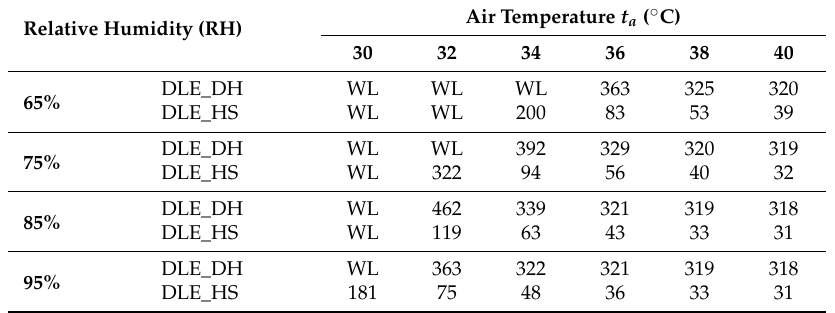
Table 1. Duration limit of exposure (min) for various air temperature and humidity inside the refuge chamber.